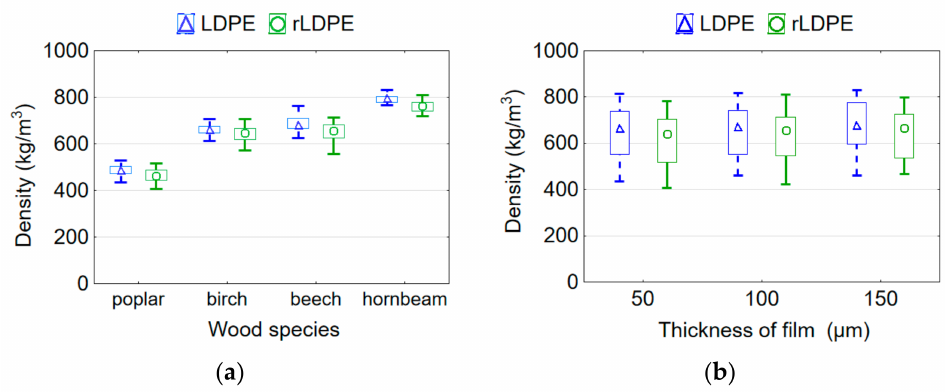
Figure 2. Mean plots of density of plywood samples depending on wood species ( a ) and thickness of rLDPE/LDPE film ( b